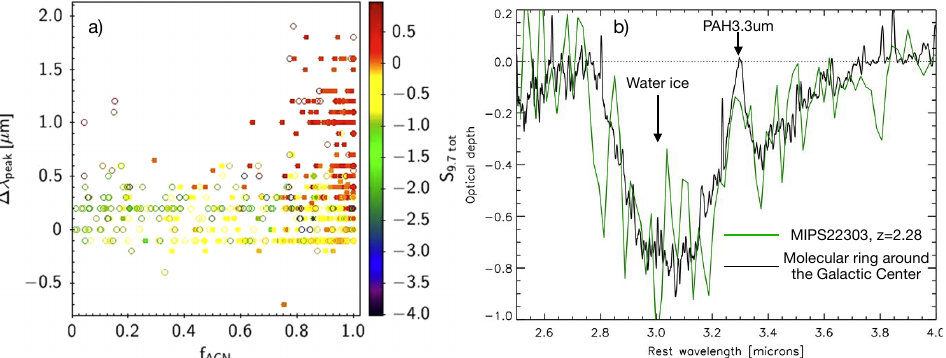
Figure 14. ( a ) The shift (relative to the canonical 9.7 µ m) in the peak of the mid-IR silicate feature, see, e.g., Figure1d, is only seen in objects with high mid-IR AGN fractions, here f AGN , and silicates in emission, here red points. Adapted from Hatziminaoglou et al. [168], with permission from the author. ( b ) Sources with deep silicate absorption also show other mid-IR absorption features such as the 3.0 µ m water ice absorption with the 3.3 µ m PAH feature often seen within that. Here, we show this behavior through the Spitzer -IRS spectrum of a cosmic noon deep silicate absorption AGN compared with the ISO -SWS spectrum of part of the molecular ring around the Milky Way Galactic Center. Adapted with permission from Sajina et al. [170], ©